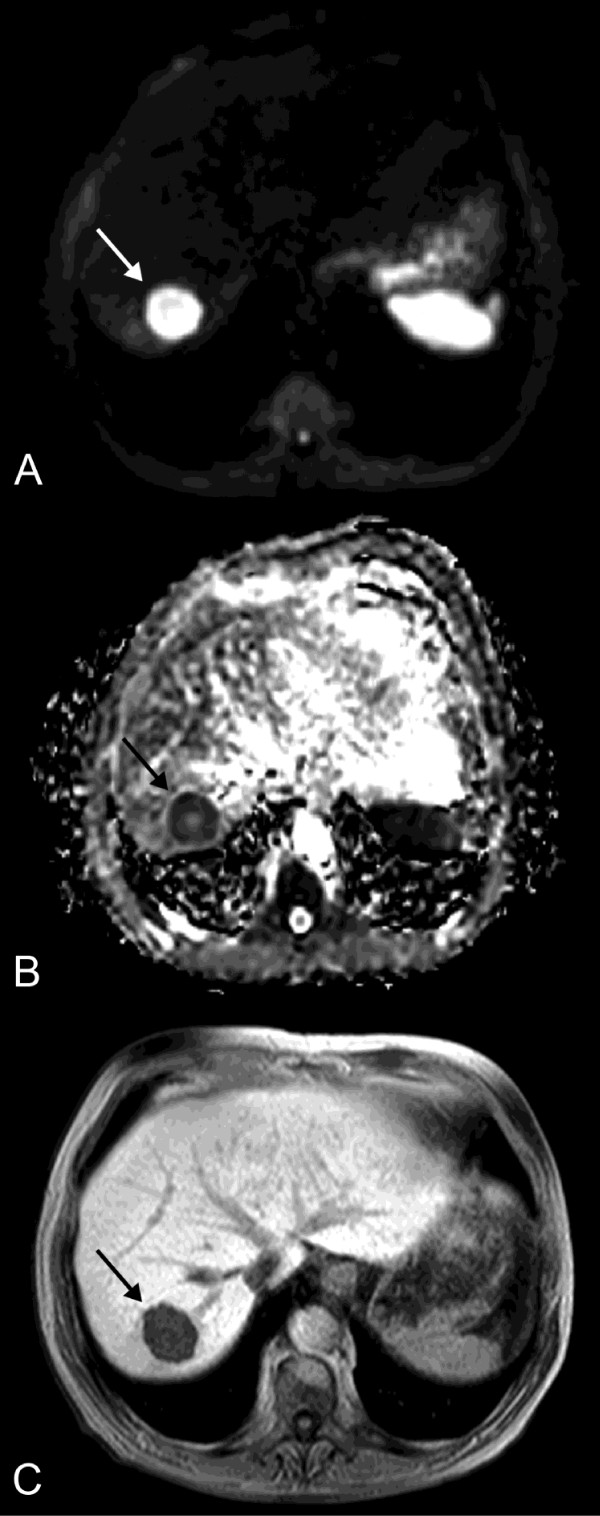
Baseline MRI preceding HDR-BT. Pre-treatment diffusion-weighted image (DWI) with b = 500 s/mm2 (A), corresponding apparent diffusion coefficient (ADC) map (B) and T1w Gd-EOB-DTPA enhanced MR image in hepatocyte-selective (hepatobiliary) phase (C) of the same patient as in Figure 1 depict the colorectal metastasis in liver segment VII with a mean ADC of 1.29 × 10-3 mm2s-1 and a mean volume of 23.3 cm3 (arrow).